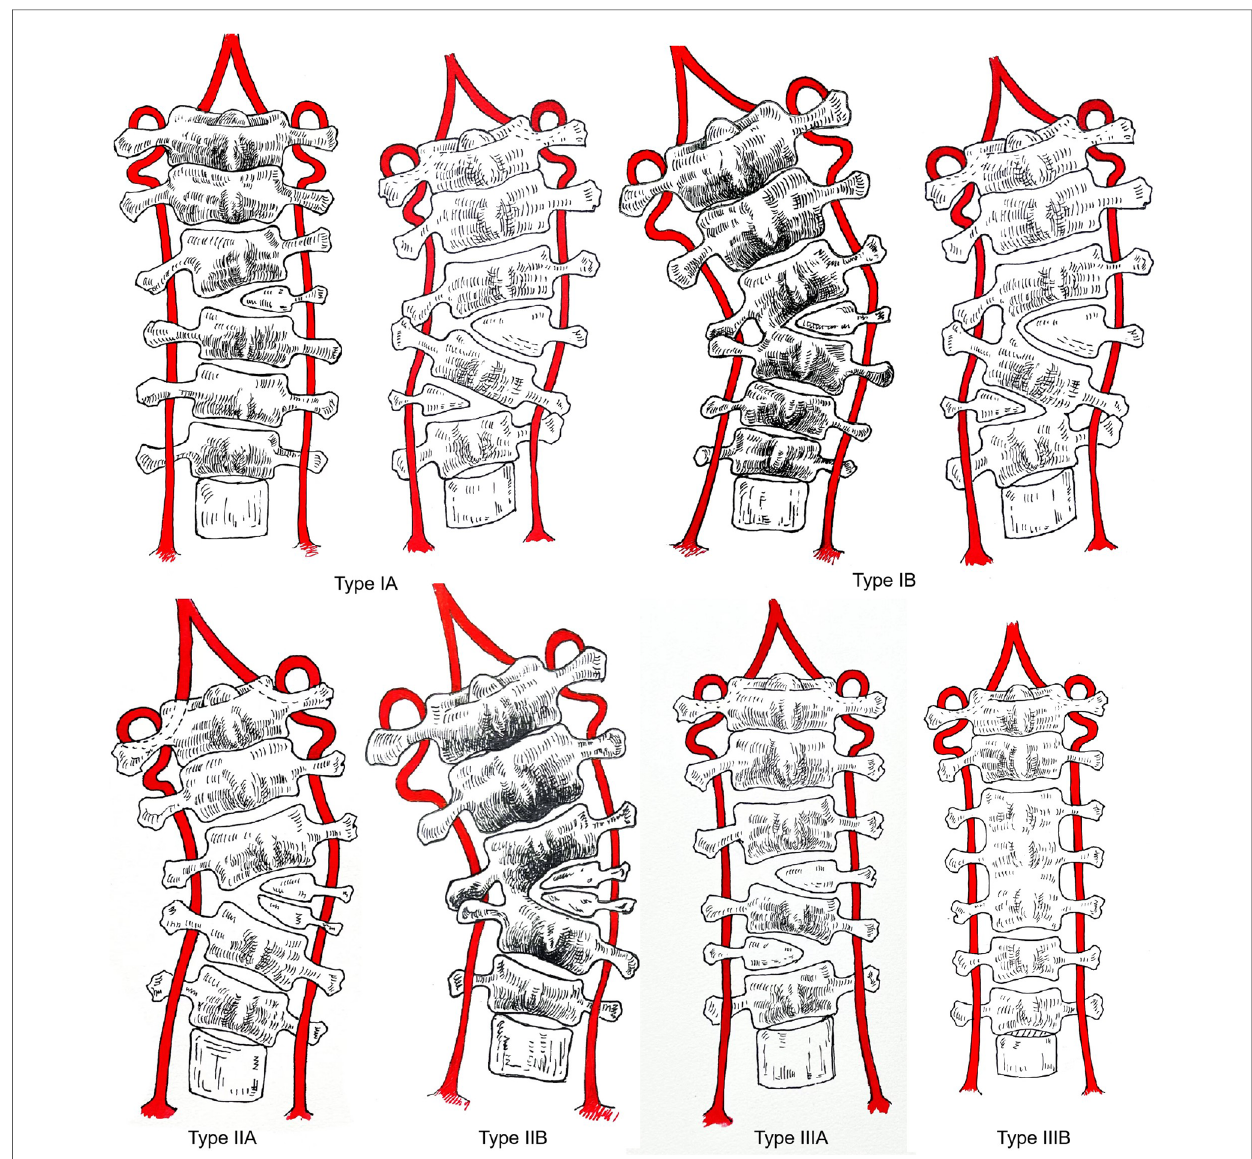
FIGURE 2 Classi fi cation of subaxial cervical hemivertebrae. Type IA: There is an obvious appearance deformity in the neck, there is a hemivertebra in the subaxial cervical and only one hemivertebra of the subaxial cervical needs to be resected to rectify the balance of the cervical spine, and the vertebra at the distal and proximal ends of the hemivertebra to be resected are not fused on the concave side. Type IB: There is an obvious appearance deformity in the neck, there is a hemivertebra in the subaxial cervical and only one hemivertebra of the subaxial cervical needs to be removed, and the vertebra at the distal and proximal ends of the hemivertebra to be resected are fused on the concave side. Type IIA: Obvious appearance deformity in the neck, there are hemivertebrae in the cervical and multiple cervical hemivertebrae need to be resected, and the distal and proximal vertebral bodies of the hemivertebrae to be resected are not fused on the concave side. Type IIB: There is an obvious appearance deformity in the neck, and there are hemivertebrae in the cervical spine. Multiple subaxial cervical hemivertebrae need to be resected, and the distal and proximal vertebral bodies of the hemivertebrae to be resected are fused on the concave side. Type IIIA: There is no obvious appearance deformity in the neck, and there are hemivertebrae in the cervical spine. IIIB: No apparent deformity of the neck or Klipper-Feil